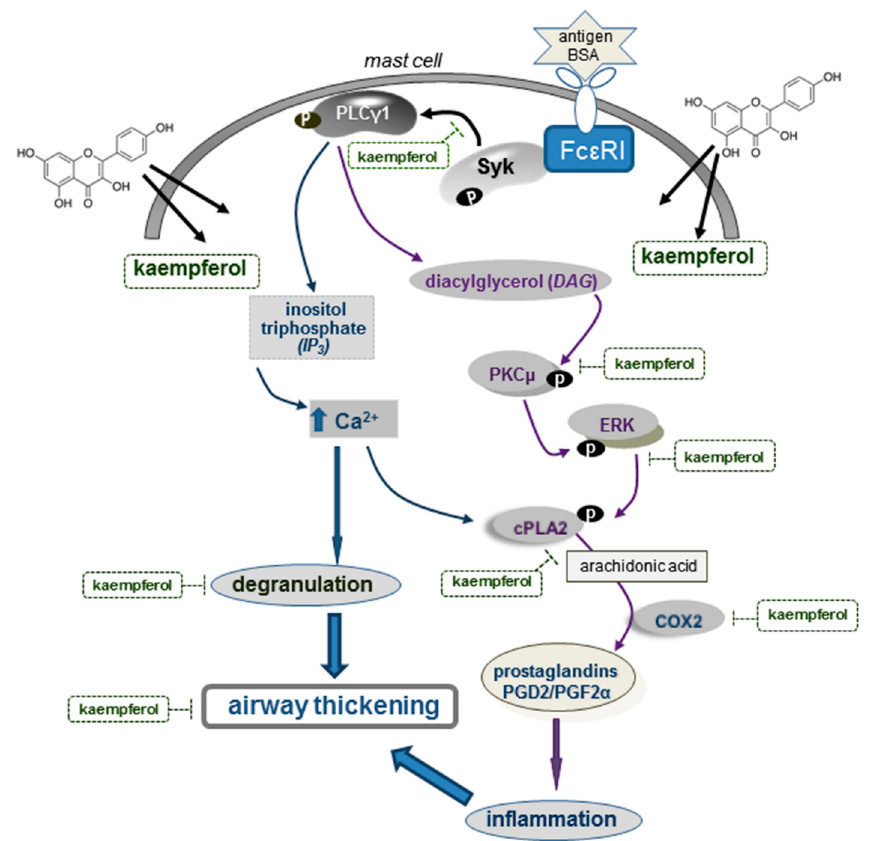
Figure 9. Schematic diagram showing the inhibitory effects of kaempferol on allergic degranulation and inflammation and its mechanistic actions in antigen-induced airway thickening. As depicted, kaempferol inhibits the direct allergic signaling cascades induced by the antigen BSA. P denotes phosphorylation. All the arrows indicate increase, activation or induction; ┥ indicates inhibition or blockade.